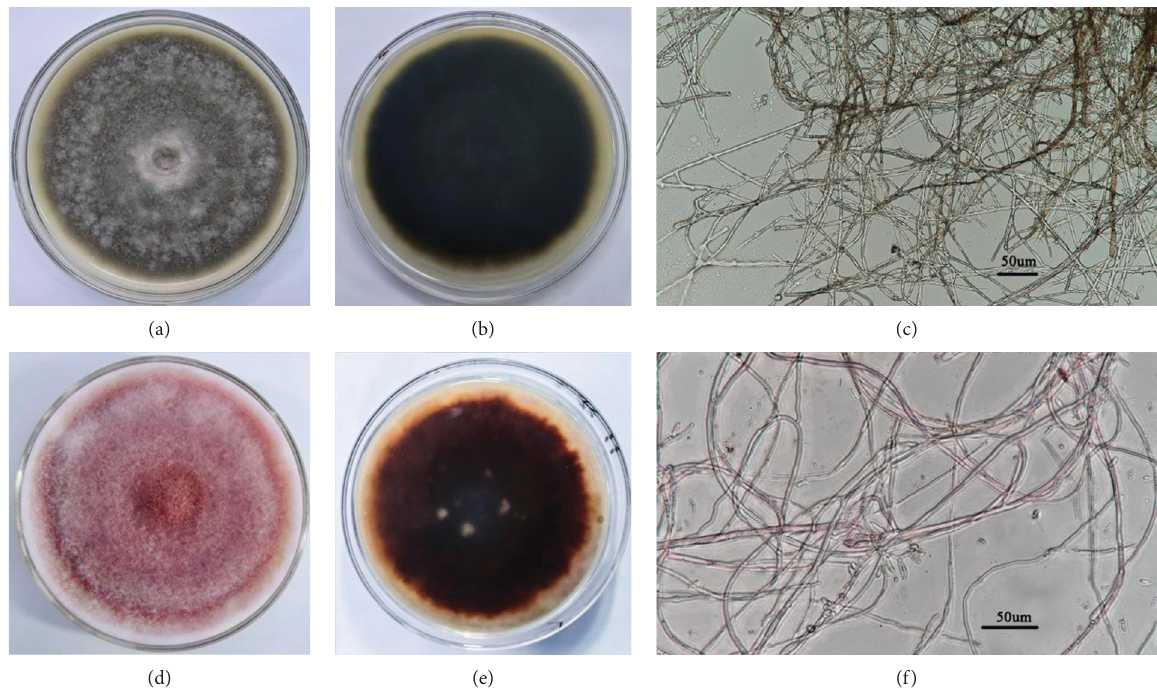
Figure 1: Morphological characteristics of F1 and F2 strains. (a)–(c) The front, back, and hyphal morphology of F1 colonies, respectively; (d)–(f) The front, back, and hyphal morphology of F2 colonies, respectively.